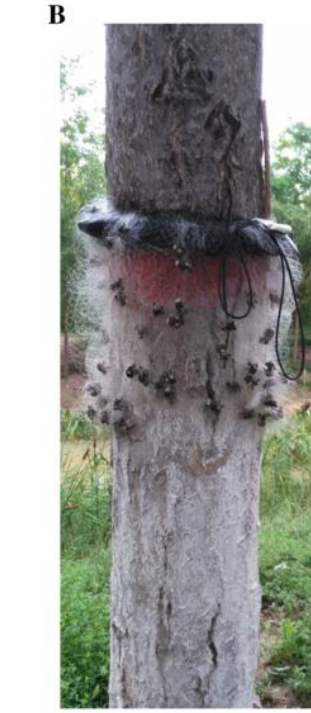
Figure 1. Trunk trap nets (TTN). ( A ) Diagram of the TTN. ( B ) TTN used in a field trial. ( 1 ) Tree trunk; ( 2 ) elastic; ( 3 ) spongy cushion; ( 4 ) netting; and ( 5 ) adhesive Velcro.